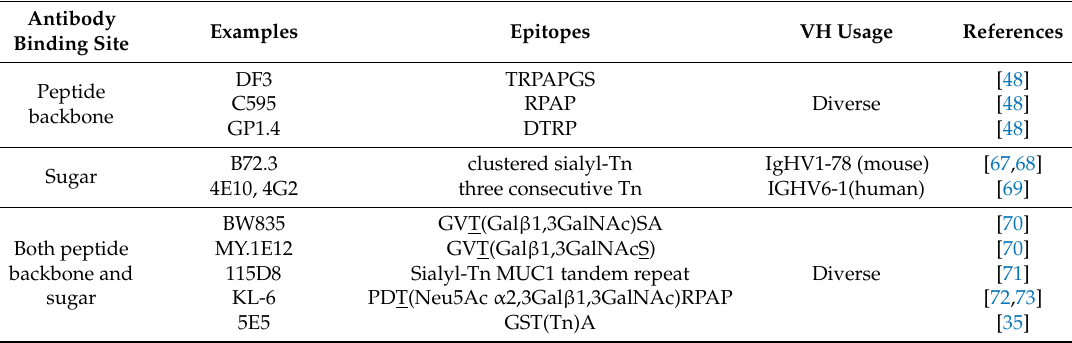
Table 1. MUC1 Glycopeptide-induced